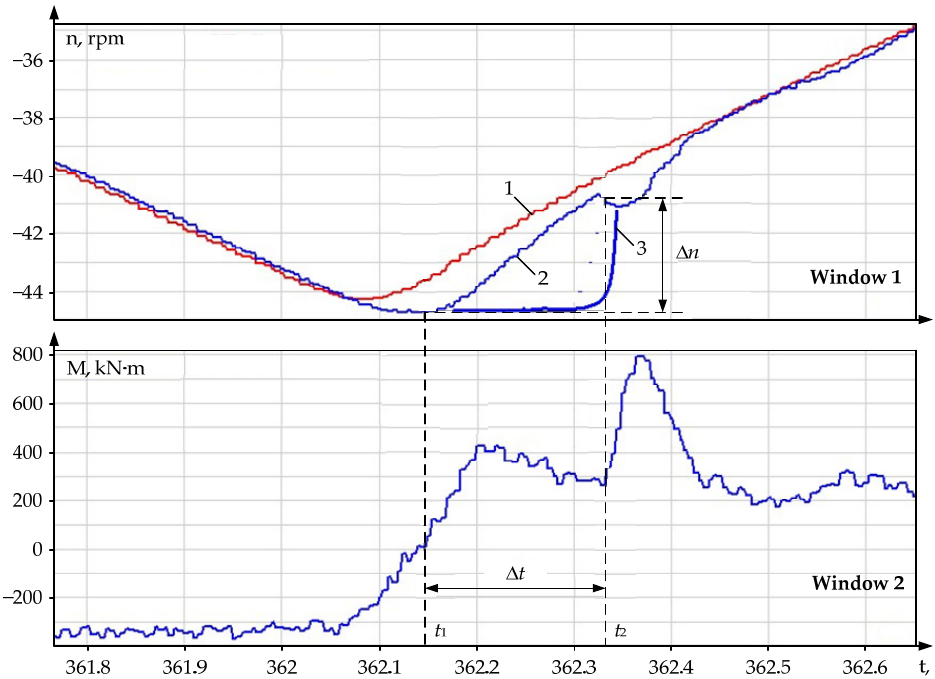
Figure 5. Angular gap reverse closing oscillograms: window 1—set (1) and actual (2) motor speeds, rpm, and open-gap speed change diagram (3); window 2—actual motor torque, kN ∙ m.